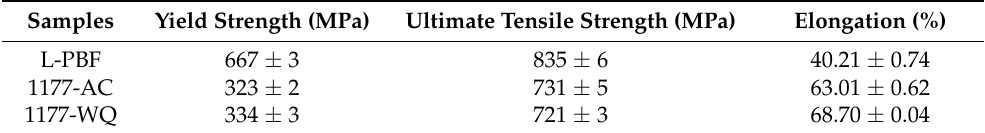
Table 2. Mechanical properties of GH3536 superalloy at room